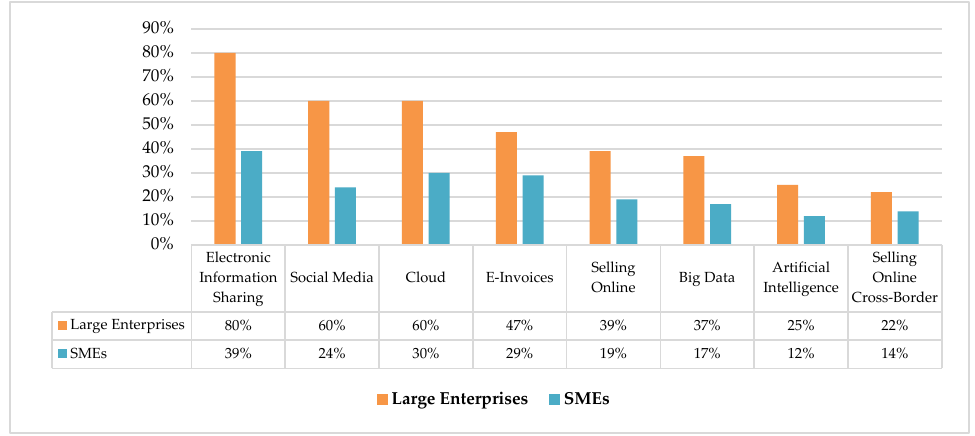
Figure 8. Adoption of digital technologies (% of enterprises—2020, 2021). Source: Authors’ compilation, according to [71] and cumulative data.